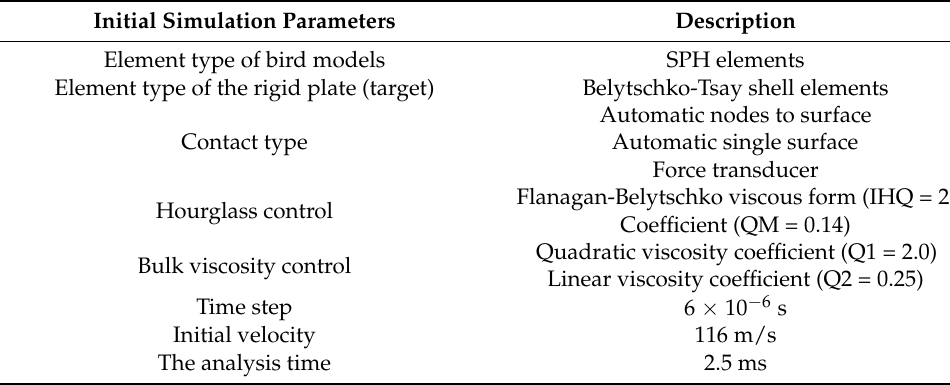
Table 3. Initial simulation